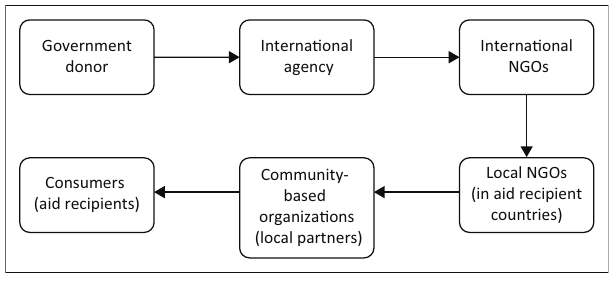
FIGURE 10: A typical humanitarian supply